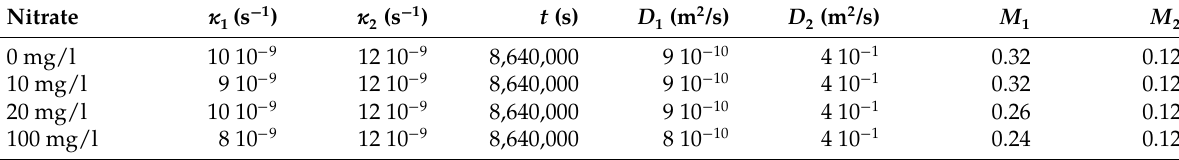
Table 4: Parameter values for Zn removal profile in case of nitrate intrusion after 100